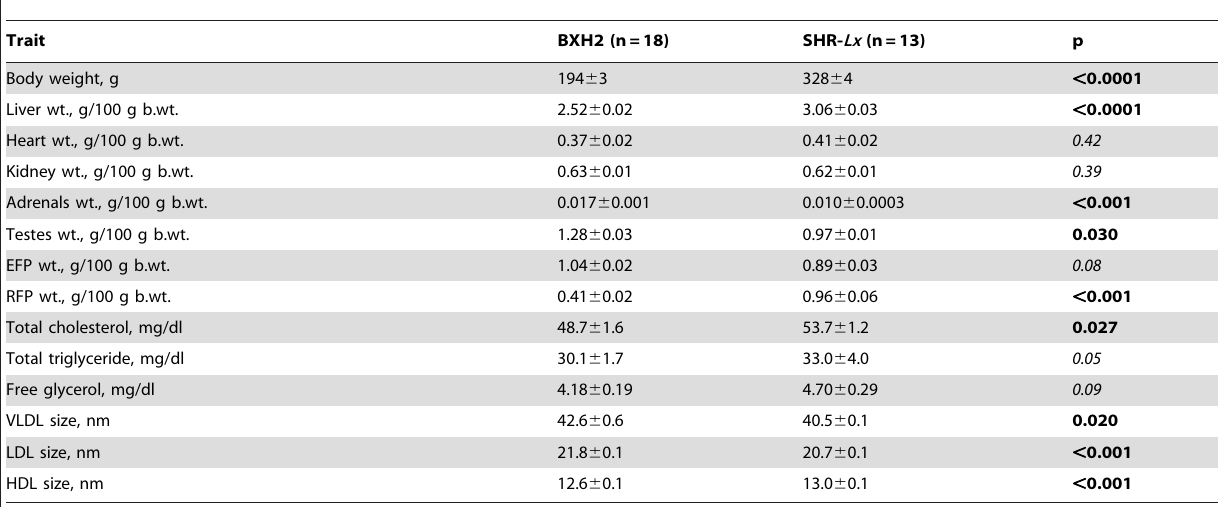
Table 1. Phenotypic comparison of BXH2 and SHR- Lx progenitor strains.